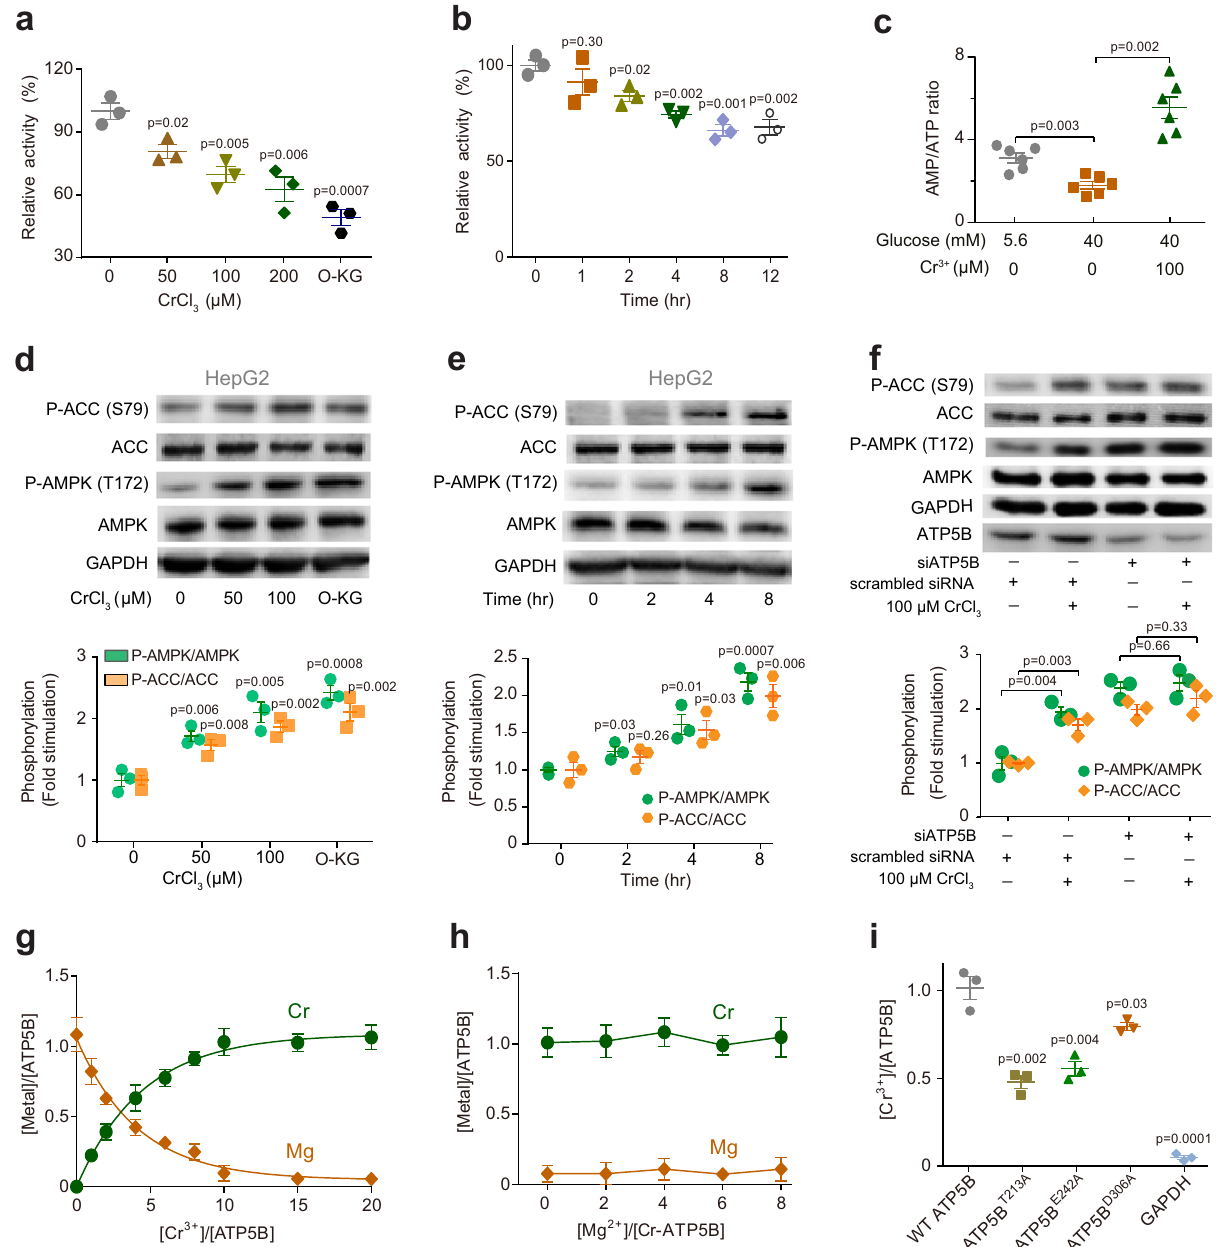
Fig. 2 | Cr 3+ attenuates ATP synthase activity and activates AMPK through binding to ATP5B catalytic site. a Dose-dependent inhibition of ATP synthase activity by Cr 3+ treatment in HepG2 cells under hyperglycaemia condition. ATP5B inhibitorOctyl- α -ketoglutarate(O-KG)isusedasacontrol. n =3;mean±SEM.Two- sidedStudent ’ s t test. b Time-dependentinhibitionofATPsynthaseactivitybyCr 3+ treatmentinHepG2cellsunderhyperglycaemiacondition. n =3;mean±SEM.Two- sided Student ’ s t test. c AMP/ATP ratios in HepG2 cells under different conditions. n =6; mean±SEM. Two-sided Student ’ s t test. d Dose-dependent and ( e ) Time- dependent activation of AMPK and ACC by Cr 3+ in HepG2 cells under